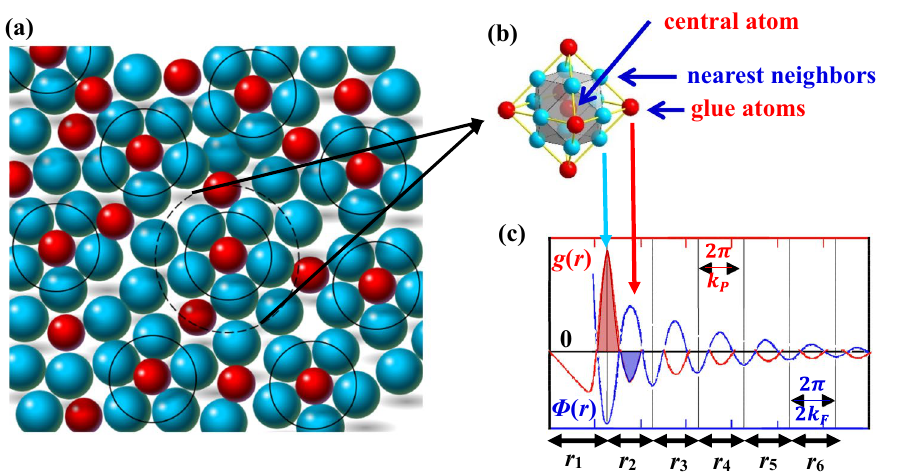
Figure 1. ( a ) Schematic diagram of short-range order and long-range disorder distribution of solute atoms in binary solid solution alloys. ( b ) Cluster configuration of binary FCC structure. ( c ) Idealized pair distribution function g ( r ) and total potential energy Φ ( r ) curve felt by electrons 12